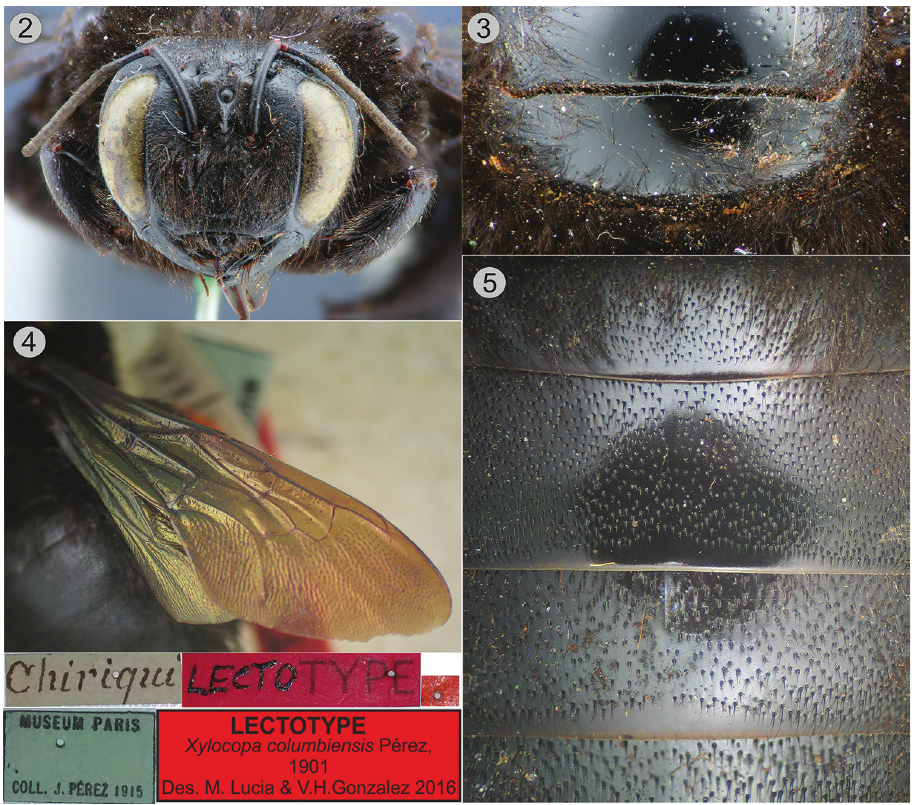
Figures 2–5. Female lectotype of Xylocopa ( Neoxylocopa ) columbiensis Pérez. 2 Facial view 3 detail of mesoscutellum 4 Right fore and hind wings 5 detail of